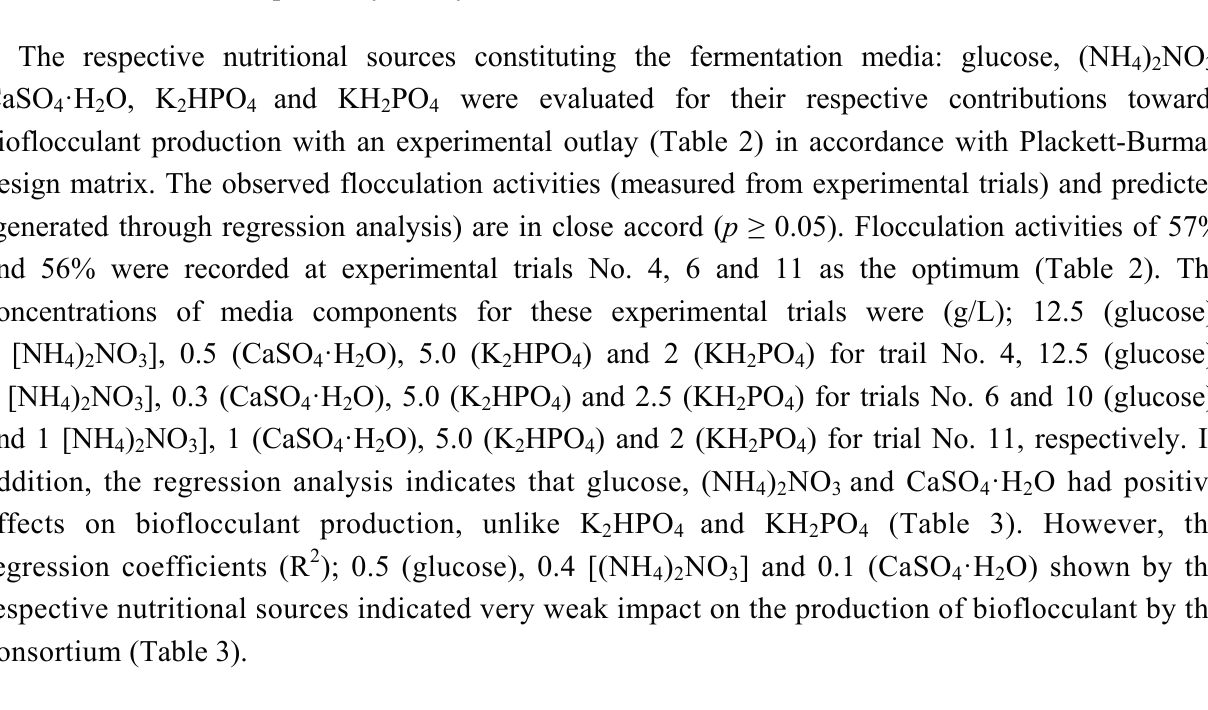
Table 2. The matrix of PB design for the determination of critical media components involved in bioflocculant production by Brachybacterium sp. and Streptomyces sp. Consortium. Runs